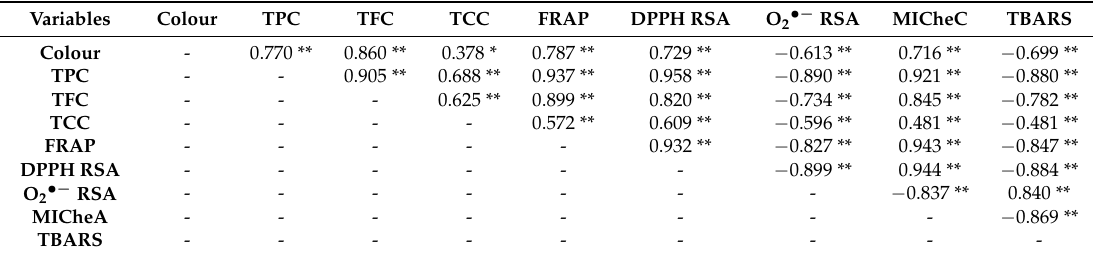
Table 2. Correlation matrix for quantitative determinations in the three monofloral honeys.